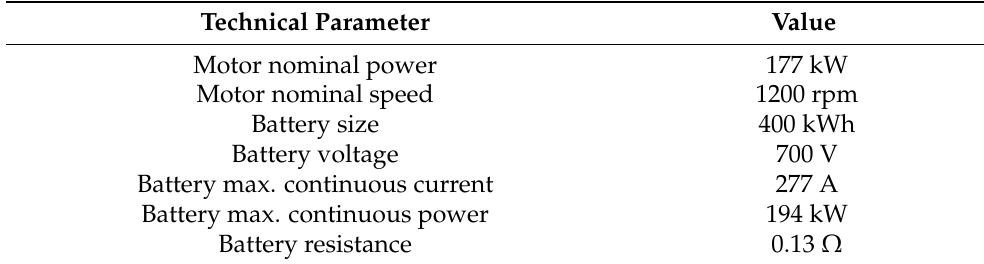
Table 2. Technical specification of the electric driveline